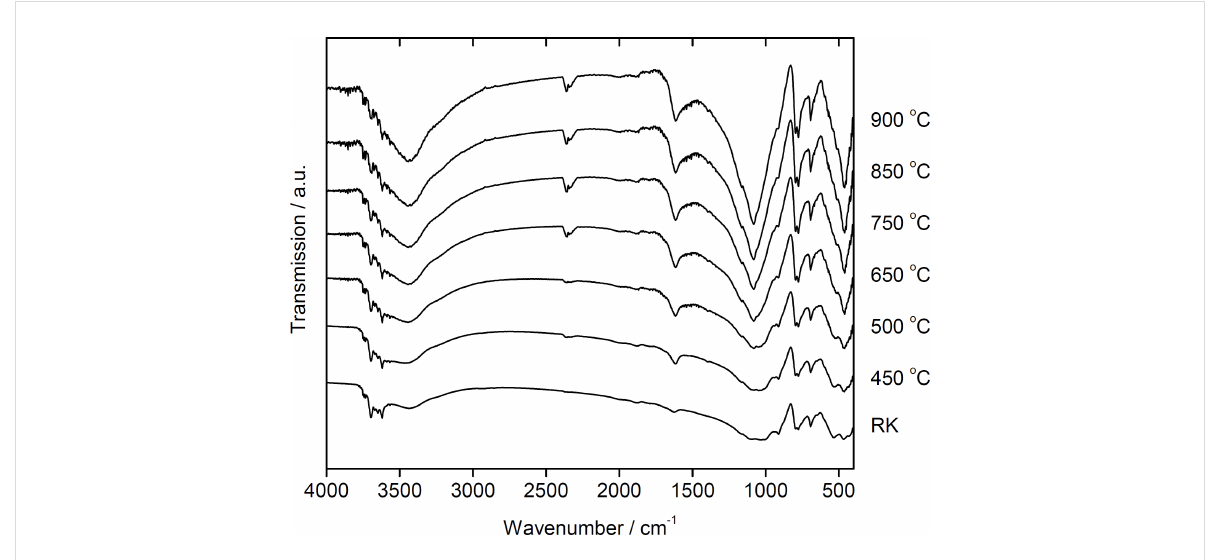
Figure 3: Fourier transform infrared spectra of the 2Z-HYCA nanocomposites obtained at various temperatures. “RK” indicates the spectrum of the raw kaolinite mentioned in the